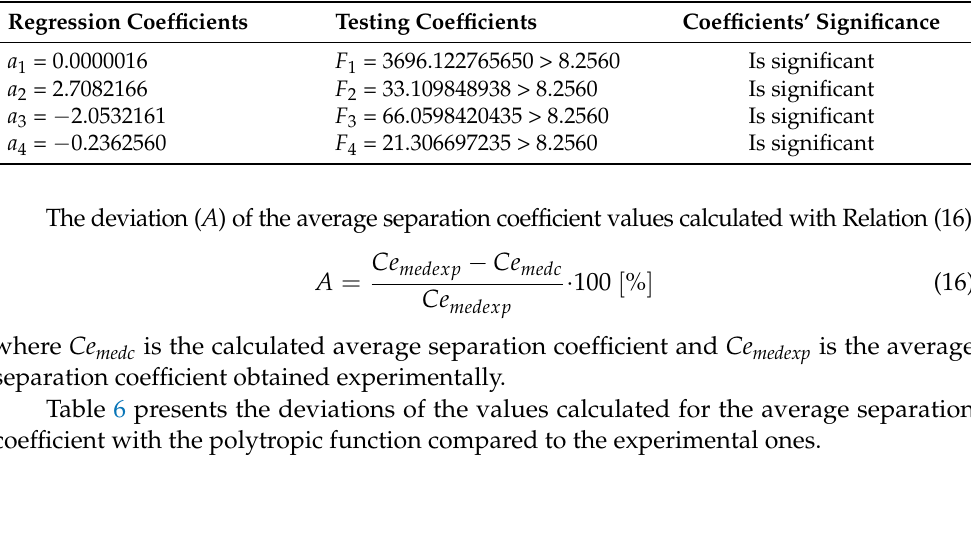
Table 5. Experimental program for polytropic